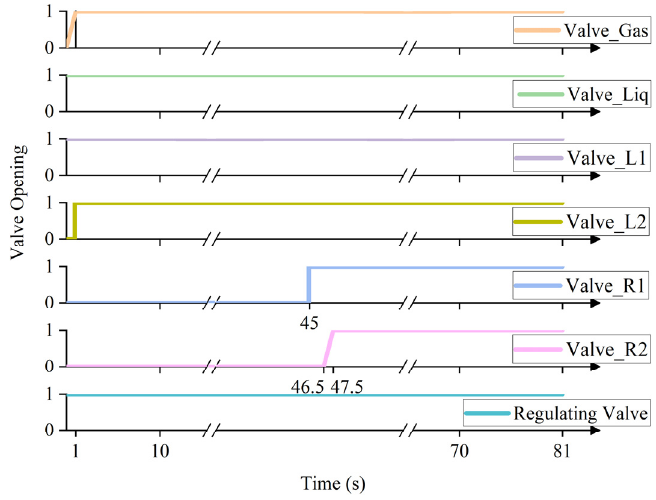
Figure 2. Working sequence of asynchronous start (Scheme ASYNC).